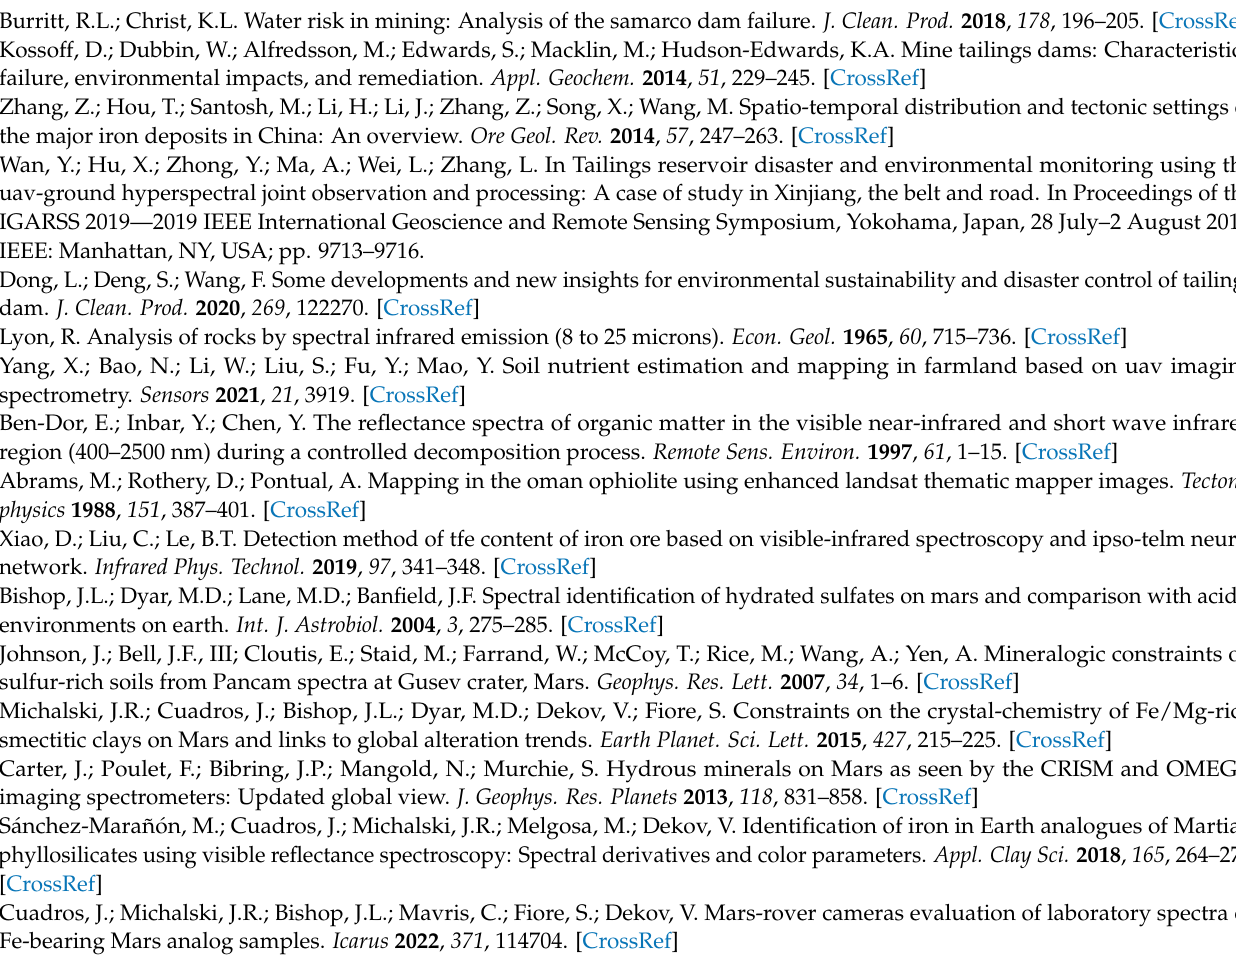
3. The combination of RF modeling and OPA-fused spectral data achieved the optimal prediction accuracy of TFe and SiO 2 compared with the accuracy obtained through individual spectra. The R 2 value increased from 0.70 to 0.91, RMSE decreased from 1.60% to 0.96%, and RPIQ increased from 1.25 to 2.31 for TFe prediction. The R 2 value increased from 0.67 to 0.95, RMSE decreased from 2.49% to 0.97%, and RPIQ increased from 2.52 to 6.49 for SiO 2 prediction. The RF model performed better than the PLSR and PSO–ELM models, with greater R 2 and RPIQ and lower RMSE